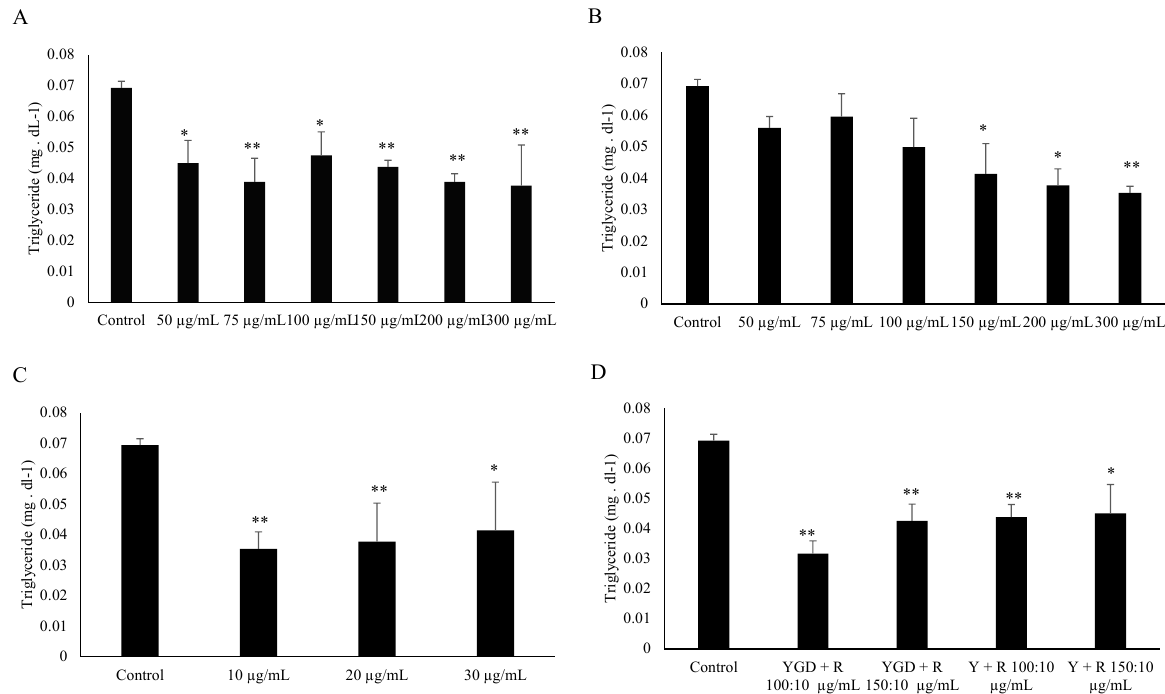
Figure 2. Effect of YGD ( A ); yerba maté ( B ); resveratrol ( C ) or mixed compounds ( D ) on adipogenesis in 3T3-L1 cells according to evaluation of triglyceride content. * p < 0.05 and ** p < 0.01 compared with control group.